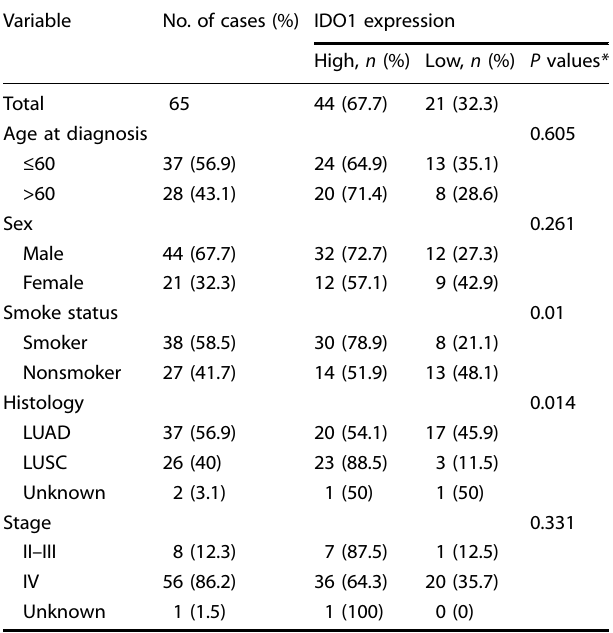
Table 2. Baseline demographic characteristics of the 65 NSCLC patients treated with an anti-PD1 antibody